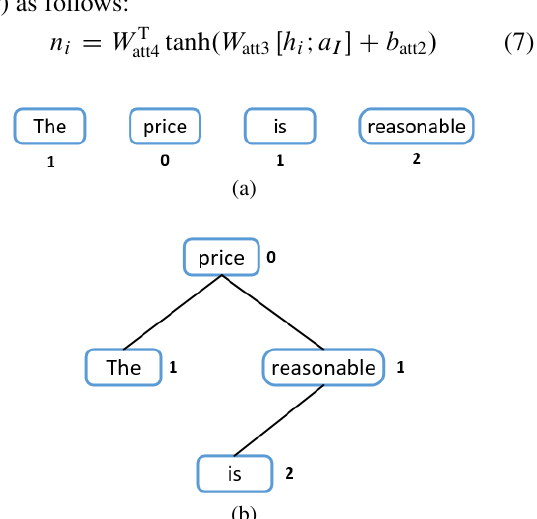
Fig. 2 (a) Position-based distance to target word “price”. (b) Syntactics-based distance to target word